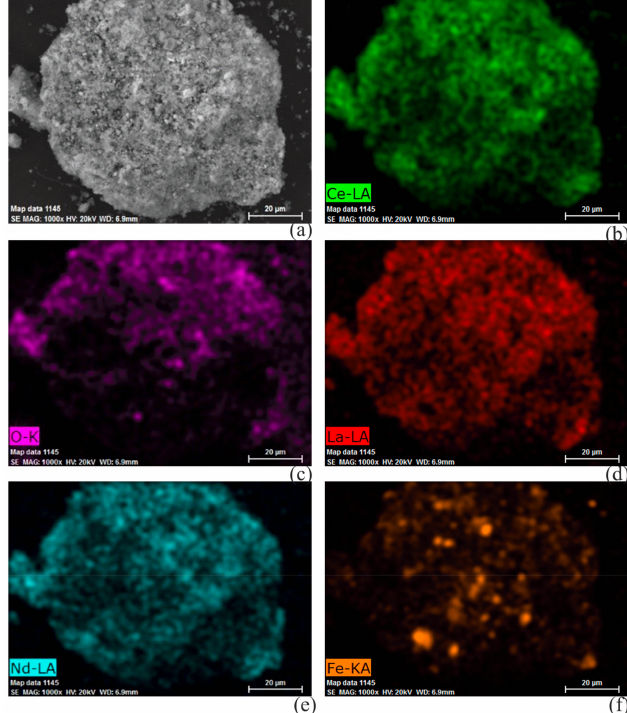
Figure 12. EDS mapping of Ce 7 O 12 particles: ( a ) SEM image, ( b ) Ce, ( c ) O, ( d ) La, ( e ) Nd, and ( f )